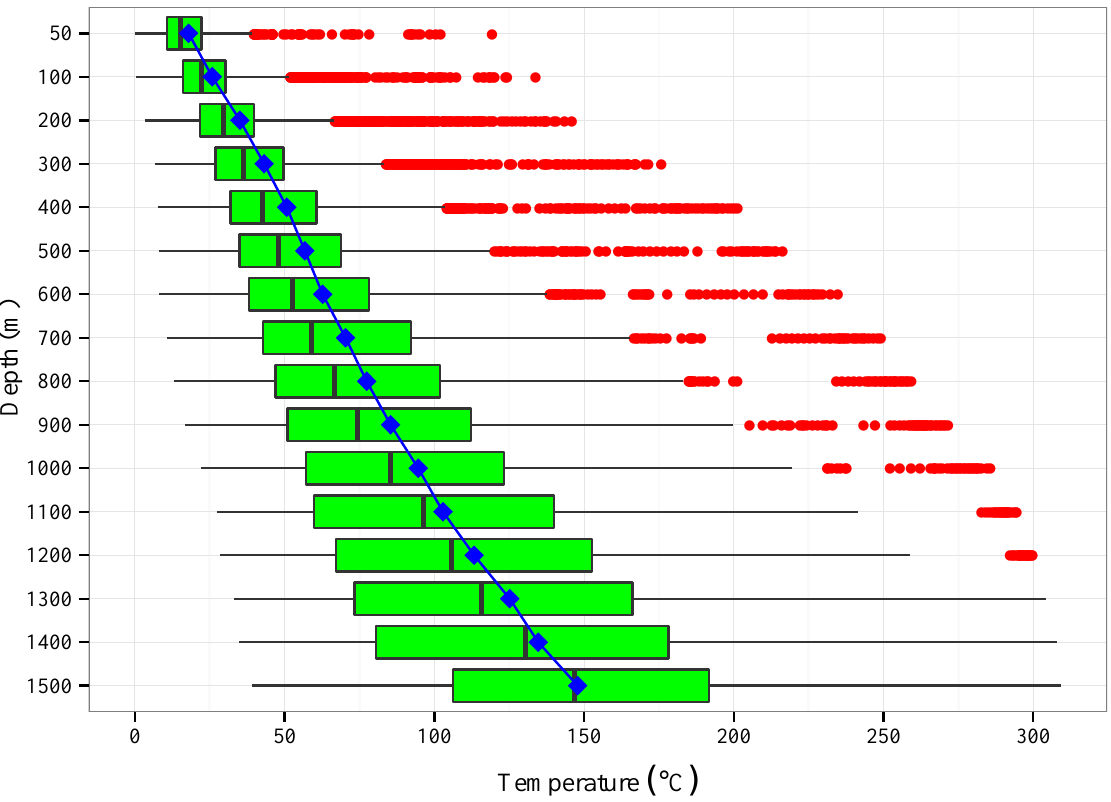
Figure 5. Box-and-whisker plot of temperature data from each depth at 100 m intervals. The blue diamonds and red circles denote mean values of the same depth group and outliers,